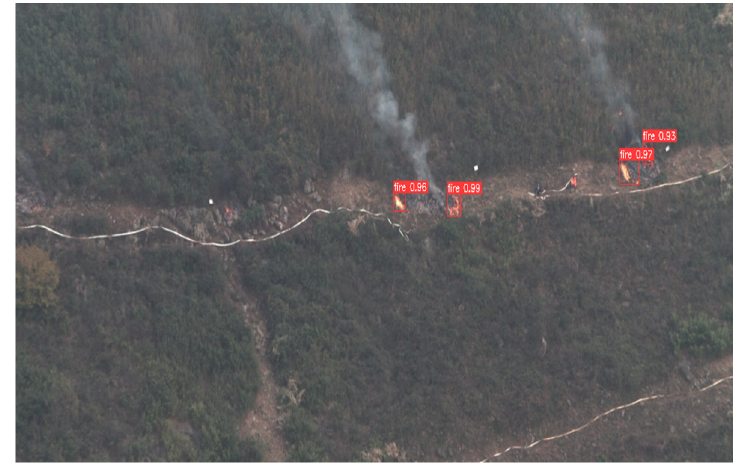
Figure 16. Detection result using STPM_SAHI.